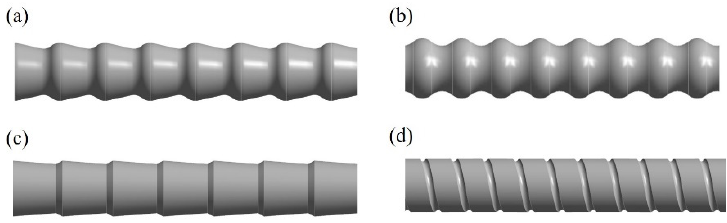
Figure 8. Geometric models of HEHE tubes: ( a ) conically corrugated tube; ( b ) arc-corrugated tube; ( c ) converging-diverging tube; ( d ) spiral grooved tube.